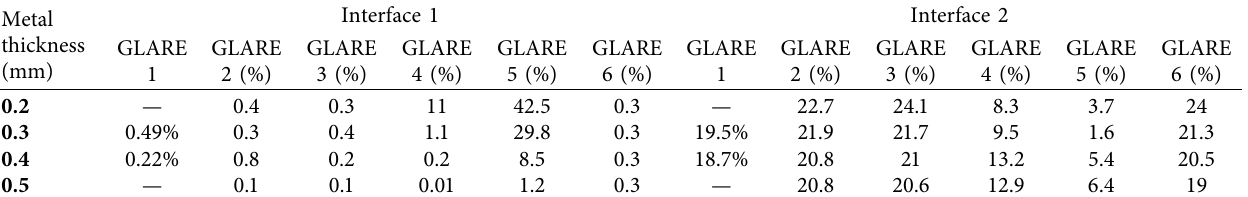
Table 6: Shear buckling capacity reduction of different types of GLARE while the initial delamination rises from 0 to 30mm. Metal thickness (mm) 0.2